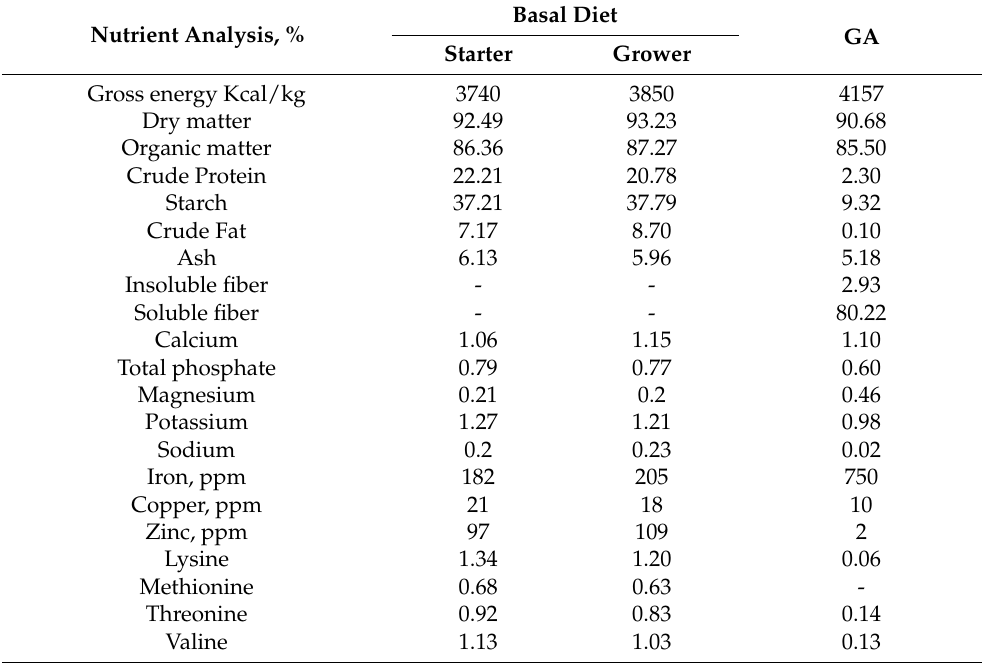
Table 2. Chemical composition analysis of basal diet and gum Arabic (GA) on a dry matter basis 1 .